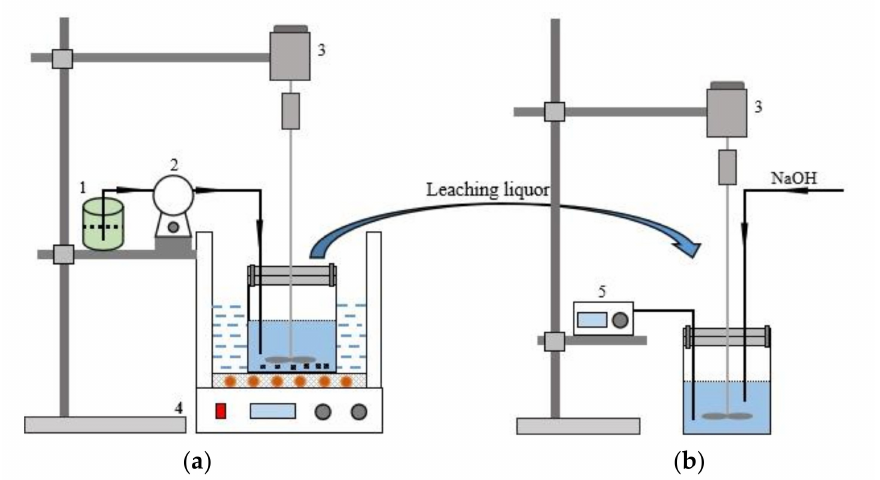
Figure 1. Schematic diagram of the leaching and separation experiment ( a ) Leaching experimental device; ( b ) Separation experimental device; (1-H 2 O 2 ; 2-Peristaltic pump; 3-Agitator; 4-Ultrasonic water bath;